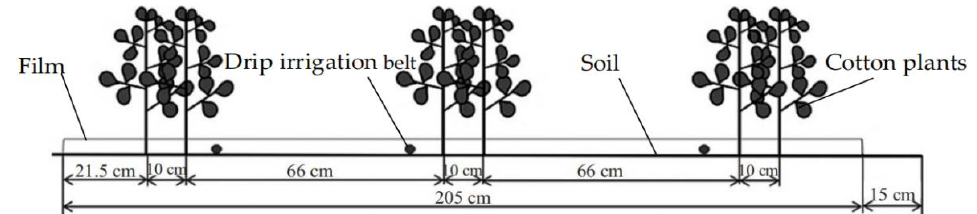
Figure 1. Ultra-wide film planting pattern of cotton.